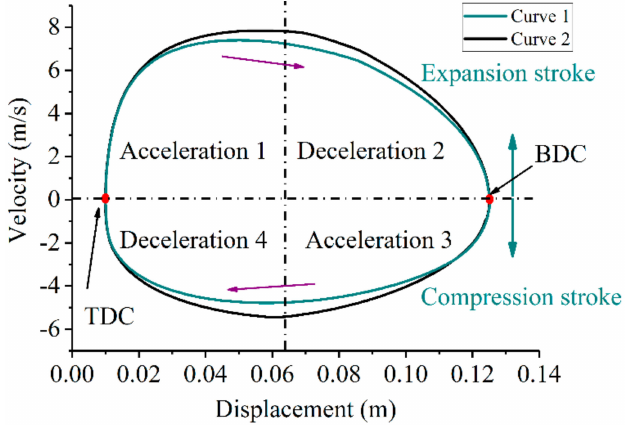
Figure 8. The phase trajectory of